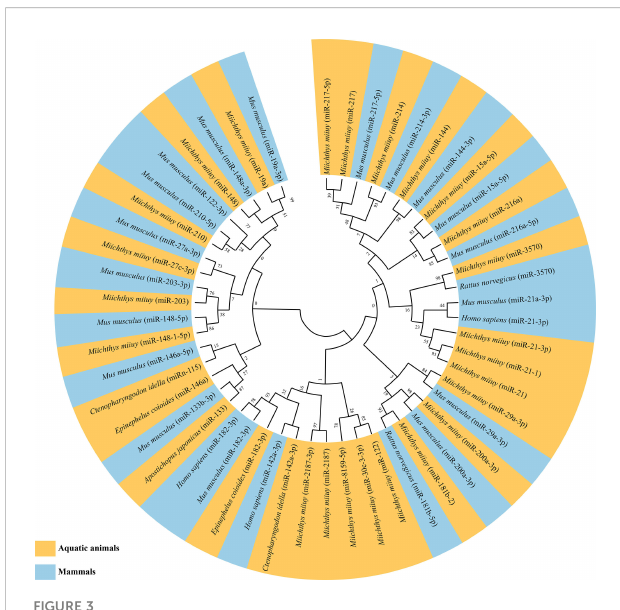
FIGURE 3 Maximum likelihood phylogenetic tree of identi fi ed microRNAs (miRNAs) regulating nuclear factor-kappa B (NF- k B) pathways in aquatic animals and mammals.